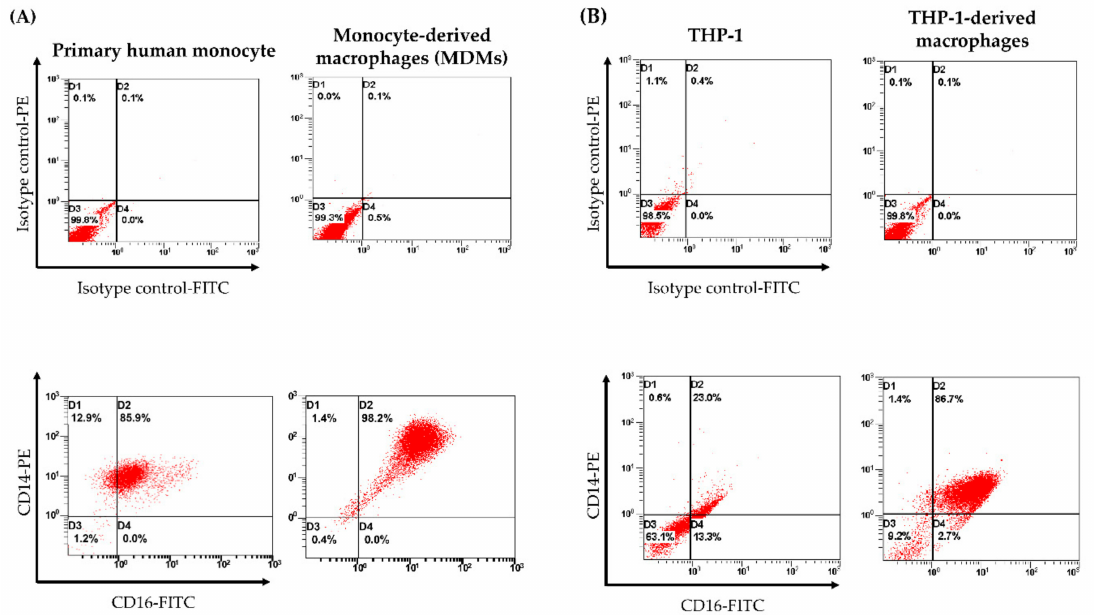
Figure 3. Flow cytometry analysis of CD14 and CD16 expression. ( A ) Expression profile of surface markers in primary human monocytes and MDMs obtained from buffy coat of a healthy donor. Percentages of positive CD14/CD16 in monocytes and MDMs were 85.9% and 98.7%, respectively. ( B ) Expression of cell surface markers in THP-1, CD14/CD16 expression was 23.0%. After differentiation with PMA, CD14/CD16 expression on cell surface increased to